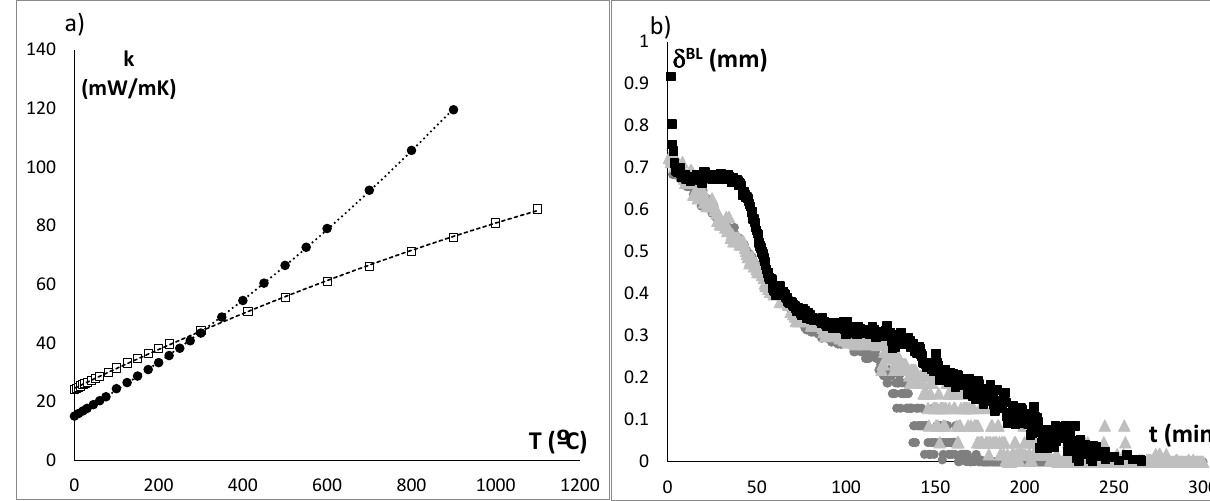
Figure 6. ( a ) Plot of the thermal conductivity of dry air (●) and vapor (□) with regards to the temperature and ( b ) plot of the boundary layer depth with regards to the drying time: HAD treatment ( ■ ), HAD + 4 W/g treatment ( ▲ ) and HAD + 6 W/g treatment (●).